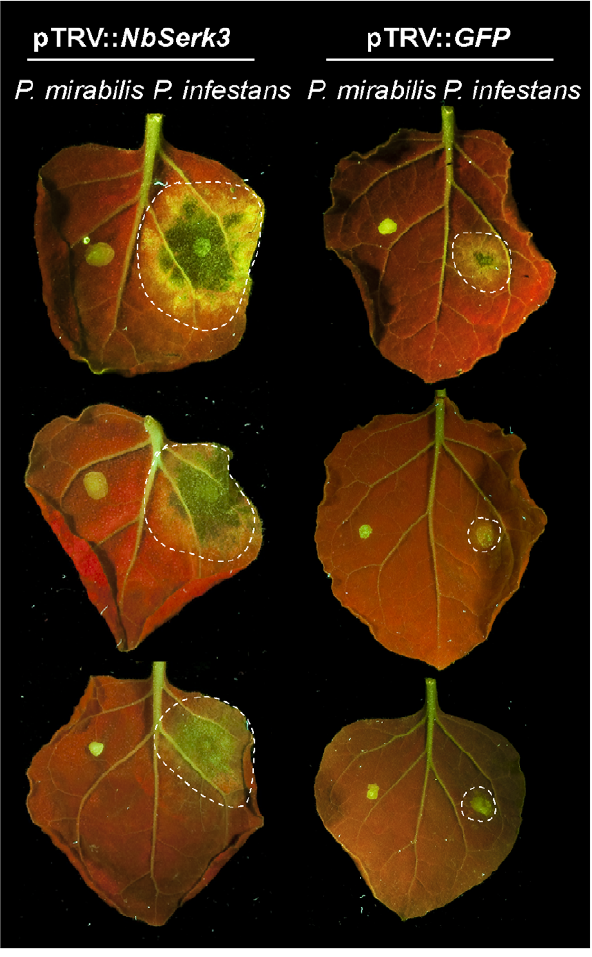
Figure 4. NbSerk3 -silenced N. benthamiana leaves are not infected by the non-host pathogen P.mirabilis. NbSerk3 -silenced (left) or control silenced plants (right) were inoculated with P. mirabilis (left leaf halves) or P. infestans 88069 (right leaf halves). Images were taken three dpi with UV illumination. Dotted lines represent infected areas. Note the occurrence of autofluorescent spots at P. mirabilis infection sites.